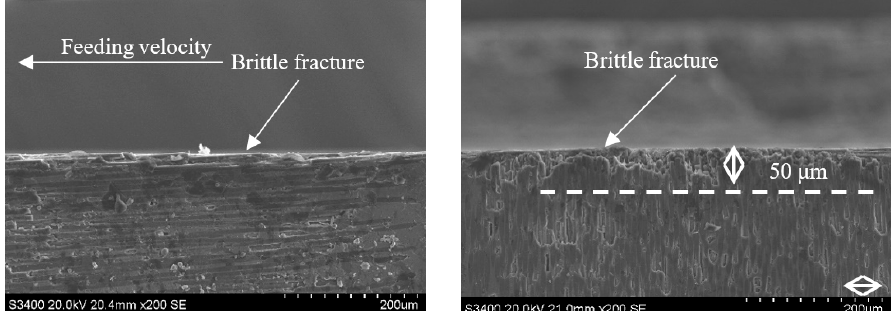
Figure 16. Grinding subsurface topography of the CG-C/SiC composite (v s = 12.6 m/s, a p = 0.1 mm, v w = 100 m/min).